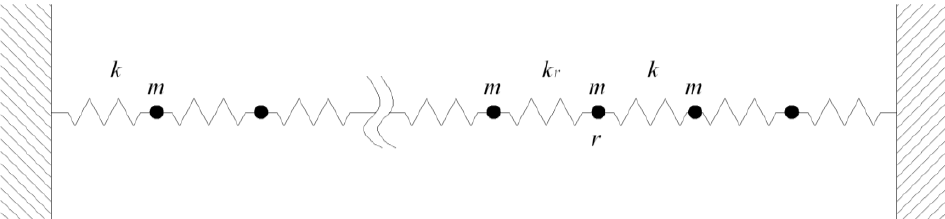
Fig. 1. Chain of resonators with stiffness